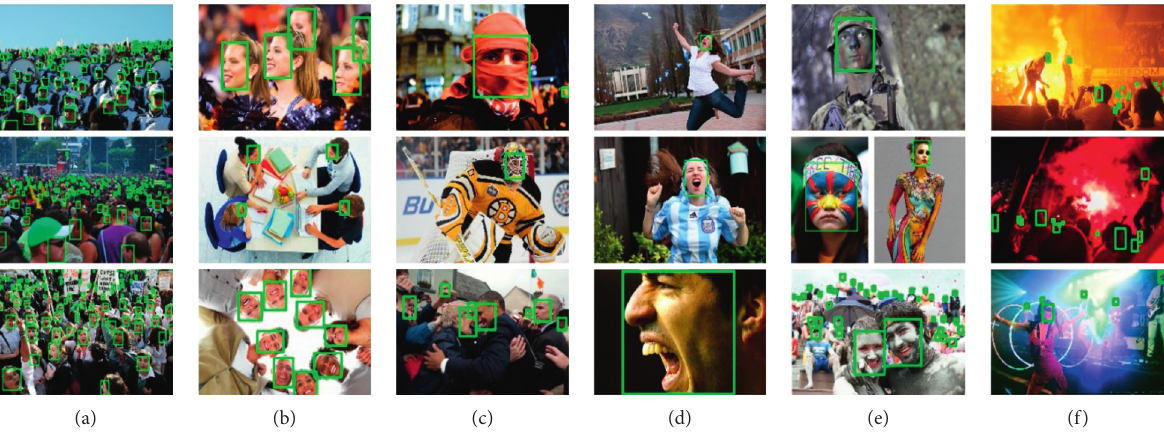
Figure 3: WIDER FACE data set